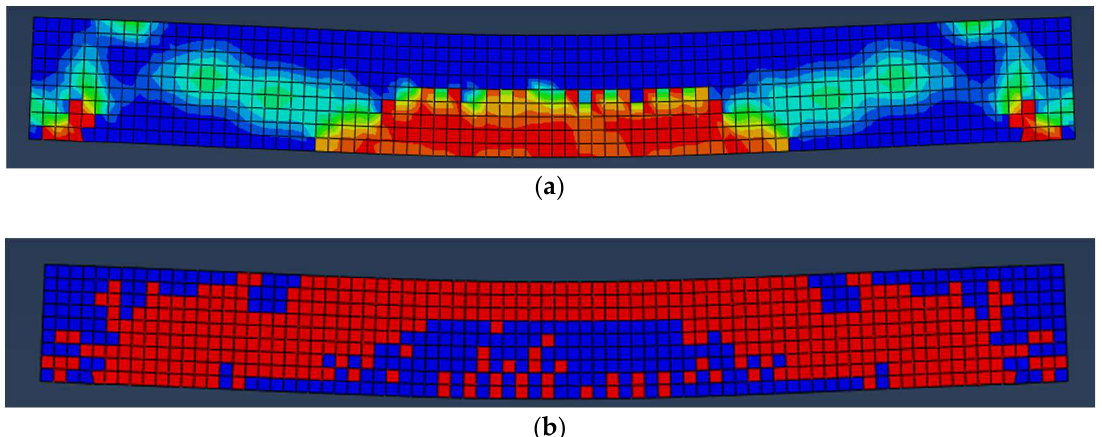
Figure 21. Analytical damage pattern of LWC beam. ( a ) Tensile damage of LWC beam; ( b ) Yield points of LWC beam.